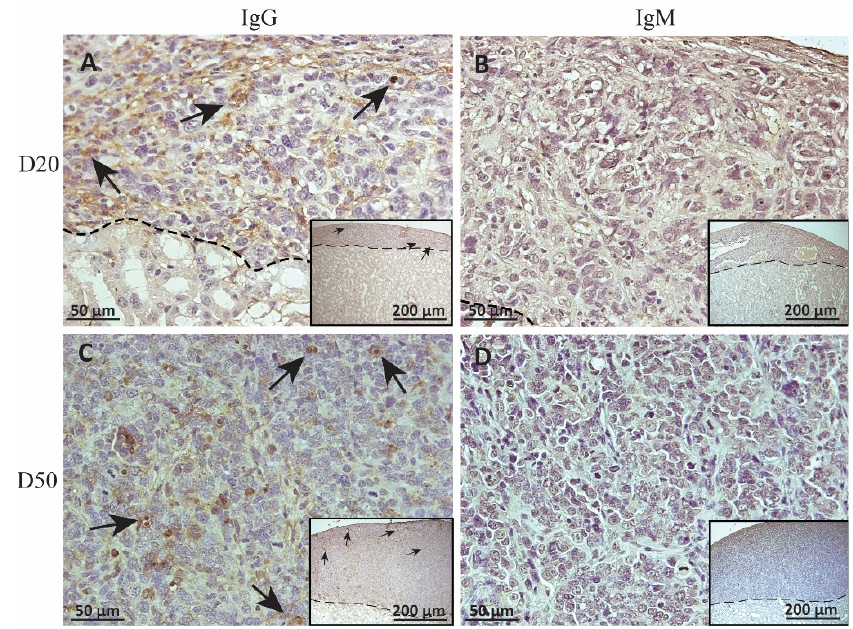
Figure 5. Immunohistochemical analysis of antibody deposition on MSC1-HI chronic timepoint allografts. Graft-bearing MSC1-HI kidneys were collected at days 20 ( A , B ) and 50 ( C , D ) post-transplantation, and tissue sections were immunostained for IgG (brown; A , C ) and IgM (brown, B , D ). Insets are lower magnification. A dotted line separates the graft from the kidney. Sections were counterstained with hematoxylin (blue). Arrows indicate examples of positive staining.